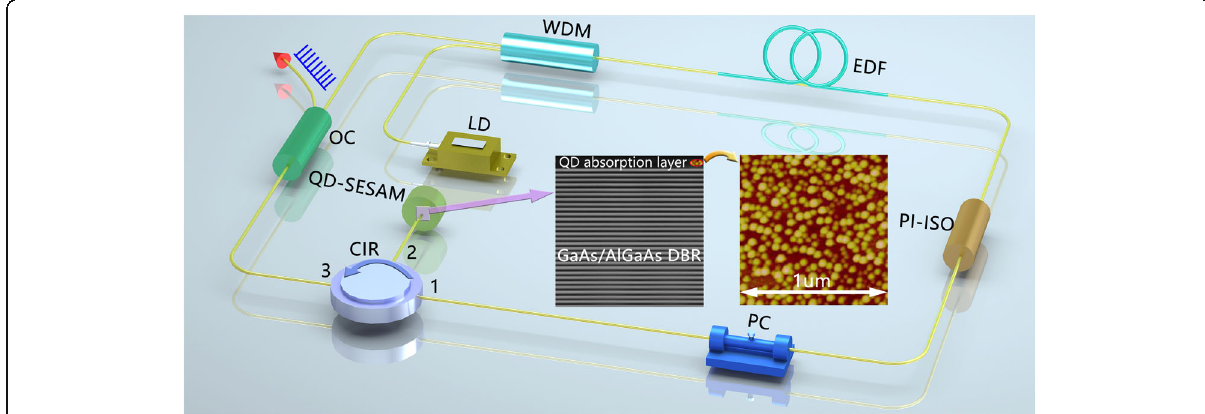
Fig. 4 Experimental setup of mode-locked fiber laser with 1550-nm QD-SESAM. Inset: cross-sectional TEM image of the QD-SESAM and 1 × 1 μ m 2 AFM image of the 1550-nm